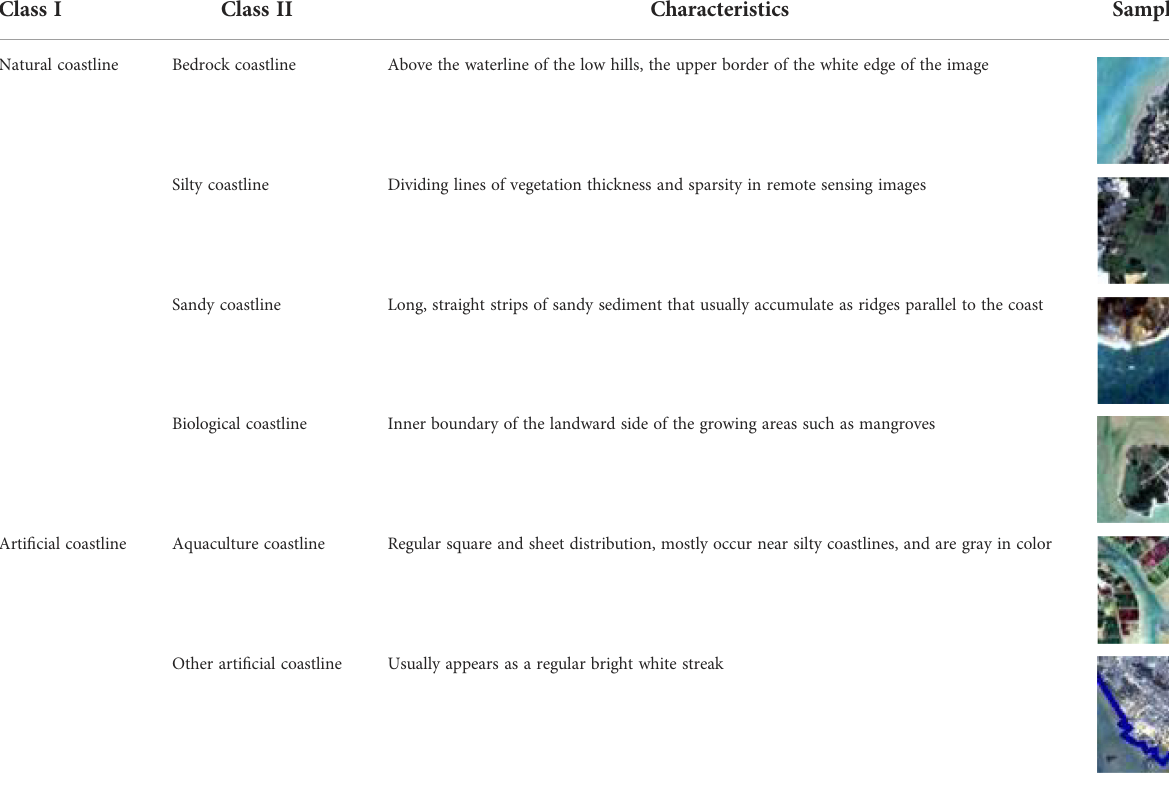
TABLE 2 Interpretation signs of coastlines in the study